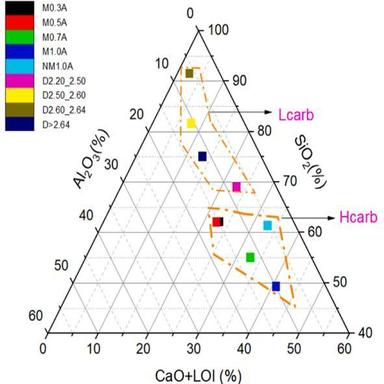
Ternary graph main oxides based in sample cluster.